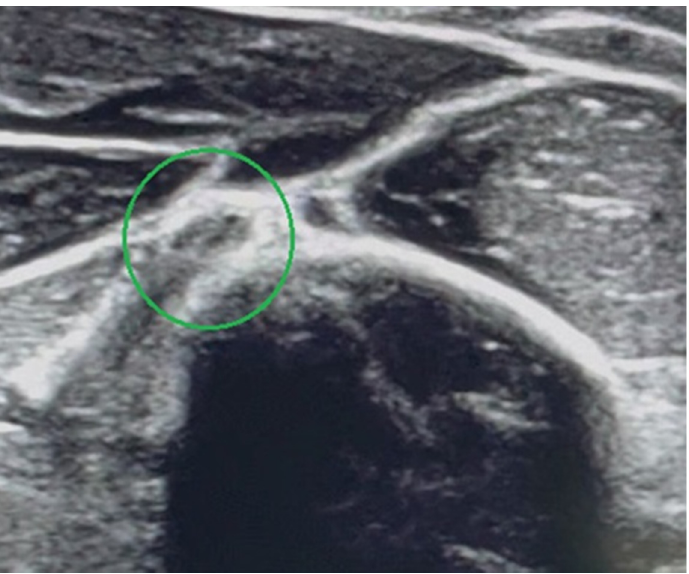
Figure 3. Ultrasound scan showing correct transverse section of radial nerve (the nerve and hyperechogenic outline of the humeral shaft are marked).